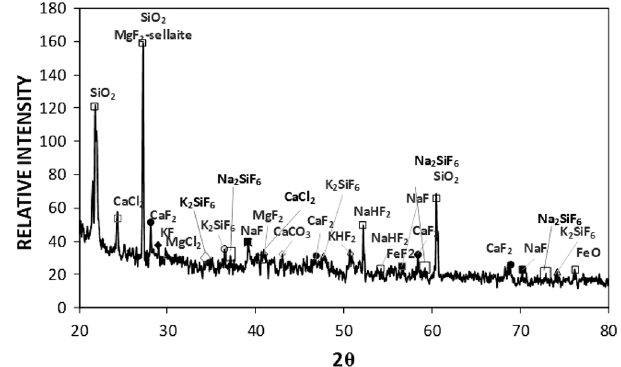
Figure 5. X-ray data for solution cured